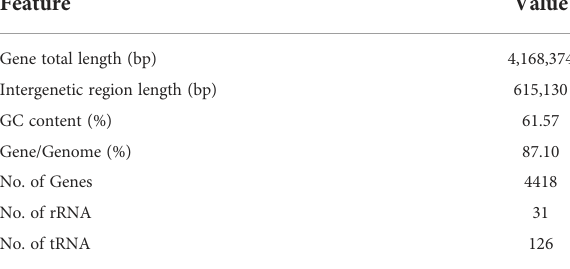
TABLE 2 General genome features of A. hydrophila